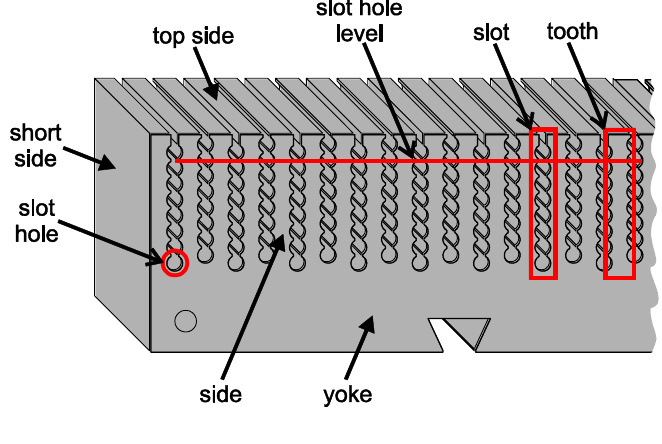
Figure 2. Definition of some key parts of the UU WEC stator section